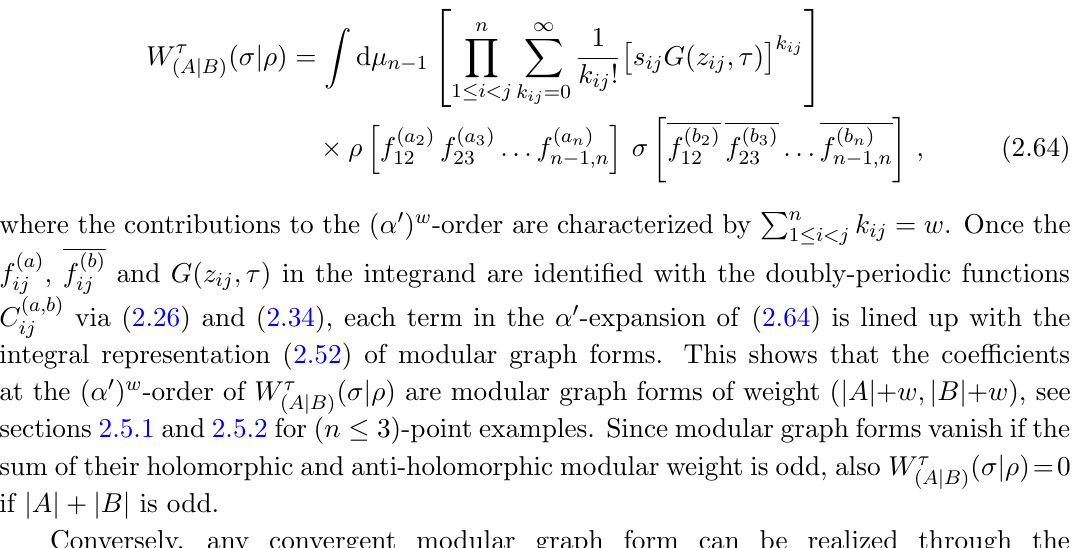
( (cid:27) j (cid:26) ) in the Mandelstam variables. Since the Mandelstams ( A j B )